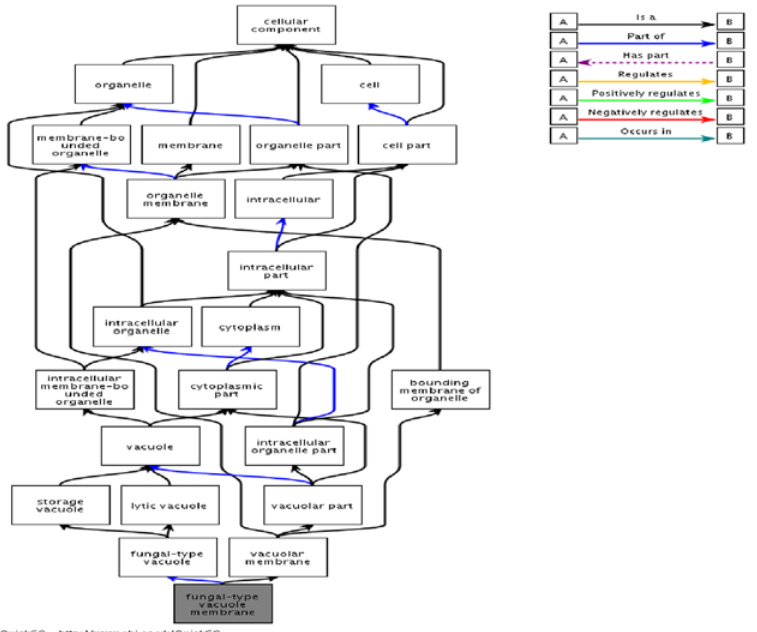
Fig 5. GO term of fungal-type vacuole membrane. Fungal-type vacuole membrane is vacuole membrane, it is the organelle membrane which belongs to cellular component. Being the largest organelles in cells of eukaryotic microorganisms, vacuoles are known to function in intracellular ion homeostasis, storage of metabolites, and degradation of proteins. Vacuoles are important for fungal responses upon berberine chloride treatment. zupT (zinc transporter), the major gene related to fungal type vacuole membrane, is up- regulated upon berberine chloride treatment. Our results suggested that up-regulation of zinc transporter zupT might be related to the compensatory ability of M . canis upon berberine